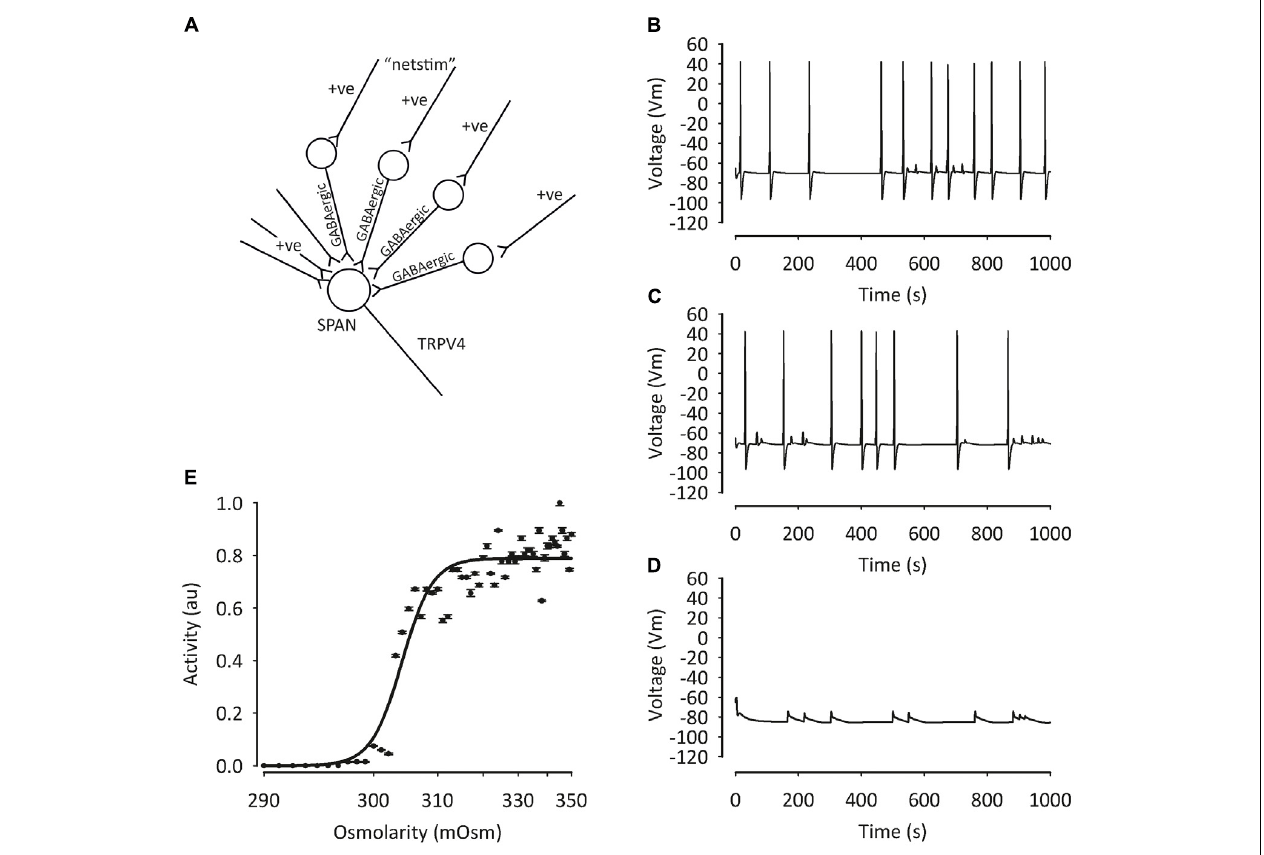
FIGURE 3 | Mathematical model of pre-autonomic neurone regulation by osmolality. To test the plausibility of our PVN osmolality conceptual model, we deployed a mathematical model written in NEURON (Feetham et al., 2015b), including intracellular Ca 2 + buffering. TRP channels were constructed as relatively non-specific cation channels with ratio (Ca 2 + : K + : Na + ) 6:1:1 and activated by hypotonicity. (A) Sympathetic pre-autonomic neurones (SPANS) receive excitatory and inhibitory input. Despite the activation of a non-specific cation channel conductance action potential frequency decreased (B) 320 mOsm, (C) 300 mOsm (D) 280